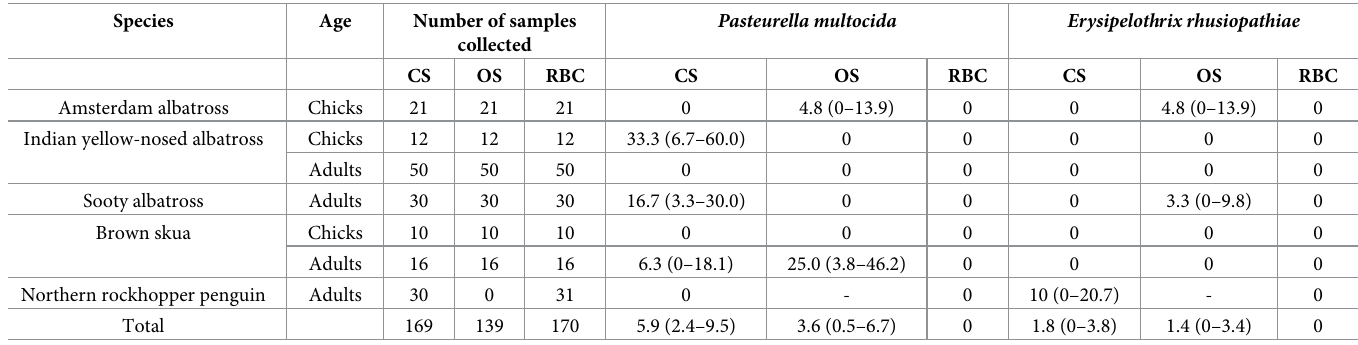
Table 1. Results of PCR detection of Pasteurella multocida and Erysipelothrix rhusiopathiae in biological samples collected between November 2011 and January 2012, from five seabird species breeding on Amsterdam Island. CS: cloacal swabs, OS: oro-pharyngeal swabs, and RBC: red blood cell samples. Values are percentages of positive samples (95% confidence